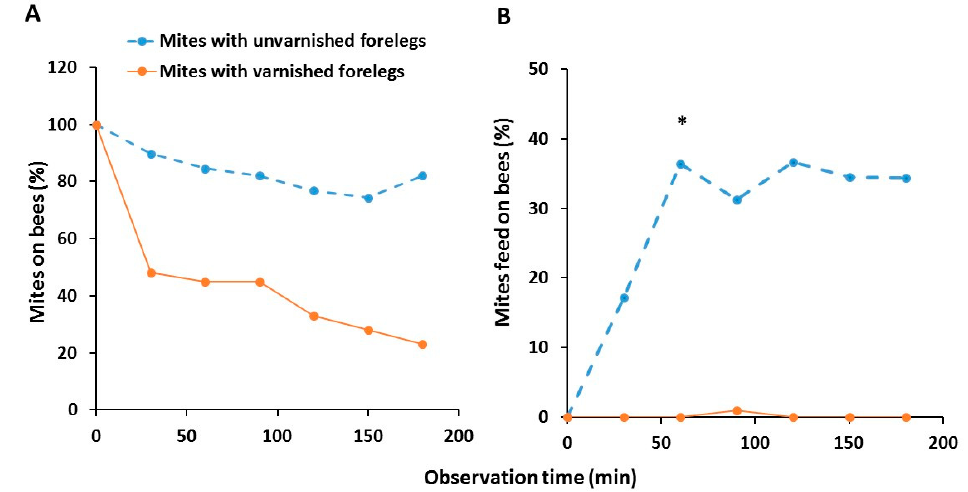
Figure 4. Ability of mites with unvarnished ( n = 39) and varnished forelegs ( n = 40) to recognize nurse bees as suitable hosts ( A ) and feed on them ( B ) after every half of hour up to 3 h. The data are percentages of all mites that remained alive until the end of the experiment. Asterisk (*) indicates significant difference in the ability to reach any host among the treatment group (Chi-Square, p < 0.05).